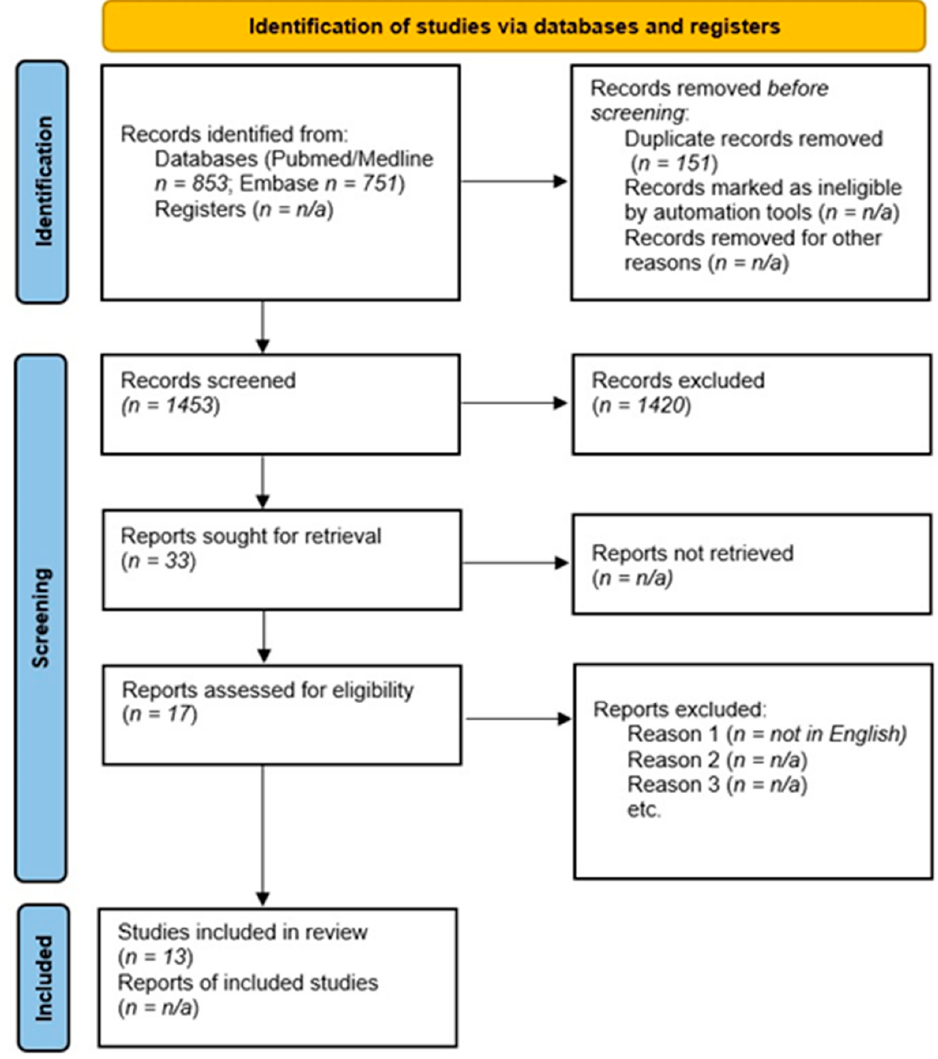
Figure 1. PRISMA flow-chart of the systematic review on leukocytosis during clozapine